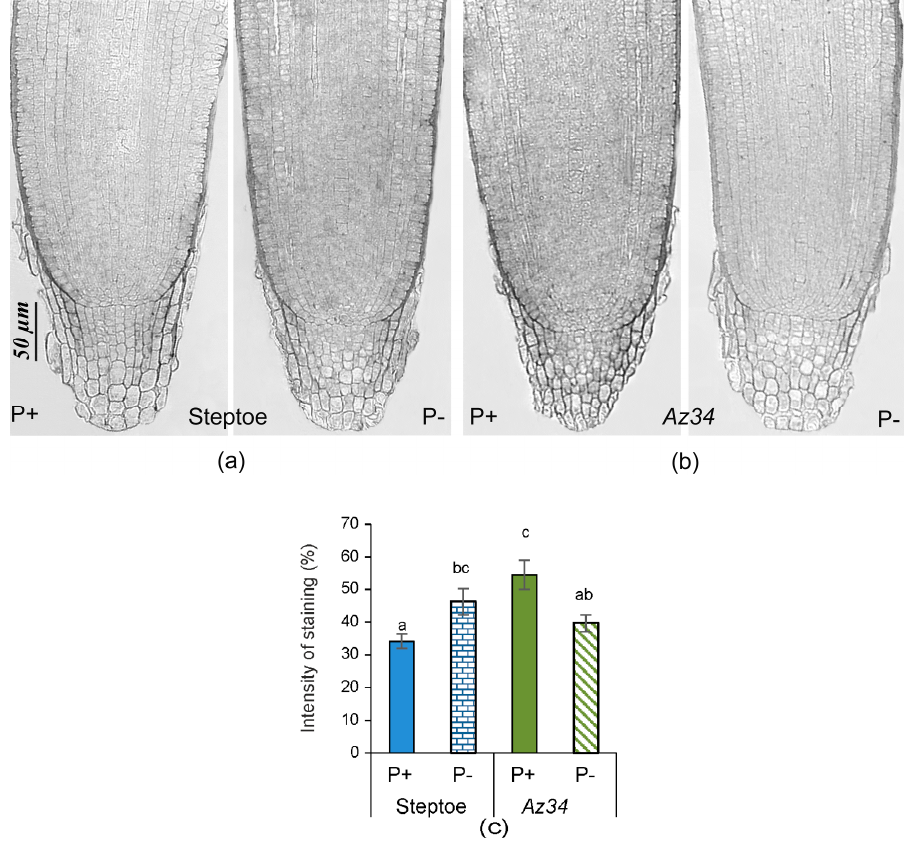
Figure 7. Immunolocalization of IAA in root tips of 4-days-old barley seedlings (cv. Steptoe ( a ) and Az34 ( b )) grown for 1 day on the nutrient solutions with (P + ) or without (P − ) phosphate. Scale bars 50 µ m. The intensity of staining was evaluated in the area shown for Figure 5a. Diagram ( c ) presents the results of a semi-quantitative assay of the intensity of staining of the tips of the root of Steptoe and Az34 plants obtained with the help of the ImageJ program [44]. Images were taken from 15 independent sections per genotype or treatment. The intensity of staining was expressed in arbitrary units, with maximal staining taken as 100% and minimal as 0 with di ff erent letters above the bars indicating significant ( p < 0.05) di ff erences according to ANOVA